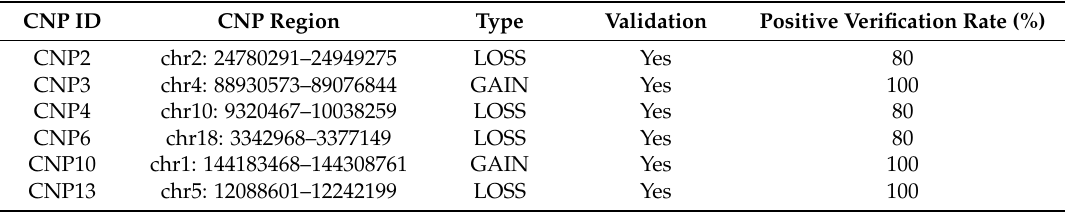
Table 5. qRT-PCR results verifying six